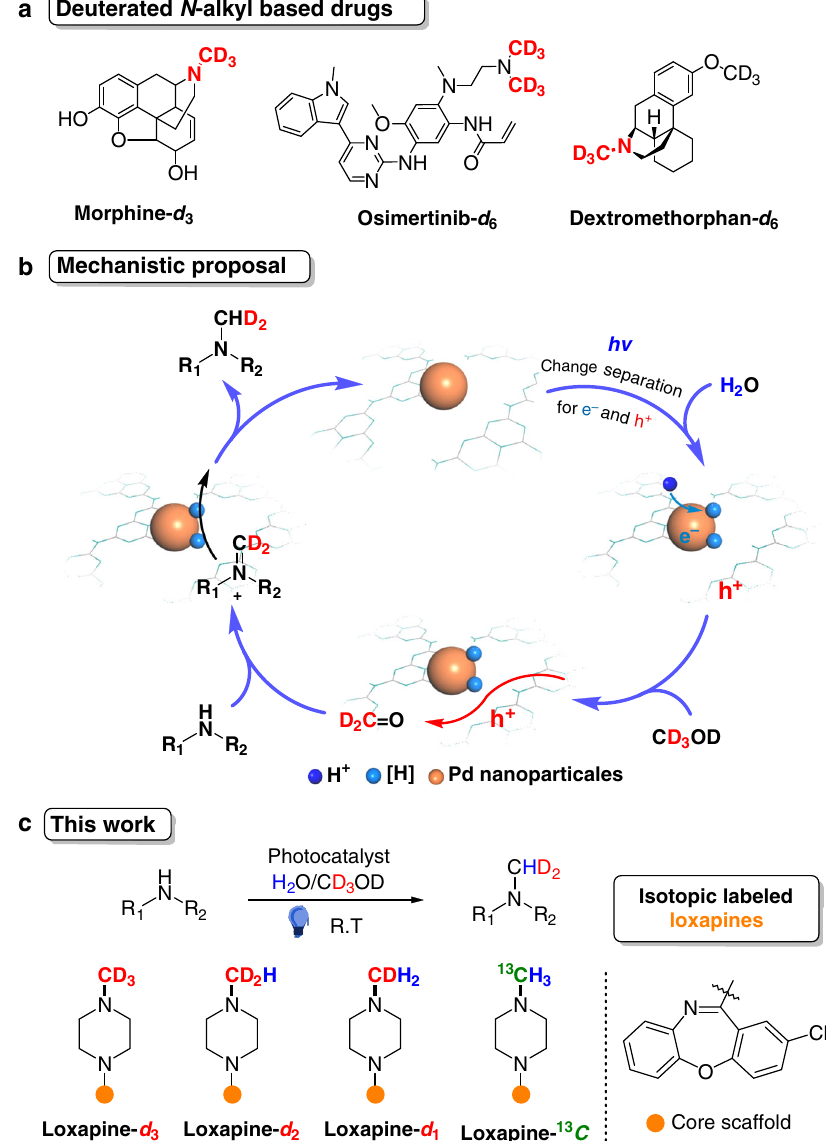
Fig. 1 Synthesis of deuterated N -alkylation drugs based on photocatalytic water-splitting process. a typical deuterated N -alkyl based drugs. b Mechanistic proposal of the controllable isotope-labeled N -methylation of amines by the synergistic utilization of electrons and holes on a semiconductor photocatalyst. c This work, and the example of practical synthesis of isotope-labeled